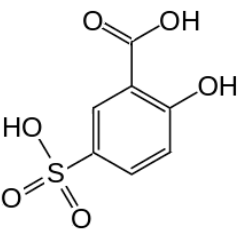
Figure 1. The chemical structure of sulpho-salicylic acid (SSA).